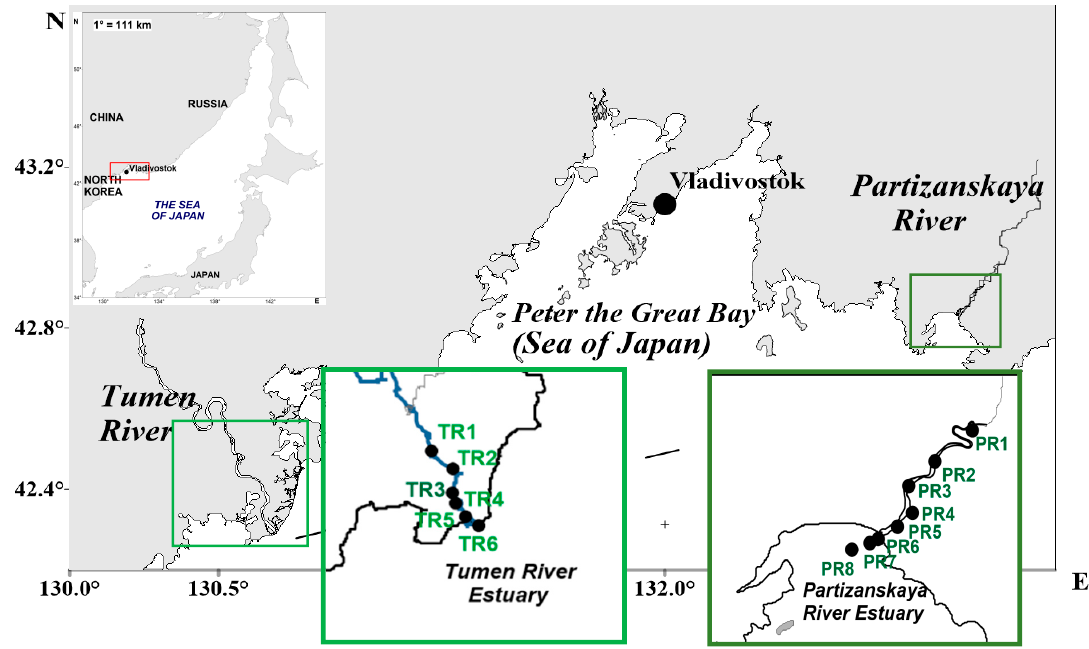
Figure 1. Location of the sampling stations in the Tumen River Estuary and the Partizanskaya River Estuary. The water samples were collected at stations TR1–TR5 in winter, TR2–TR6 in summer and